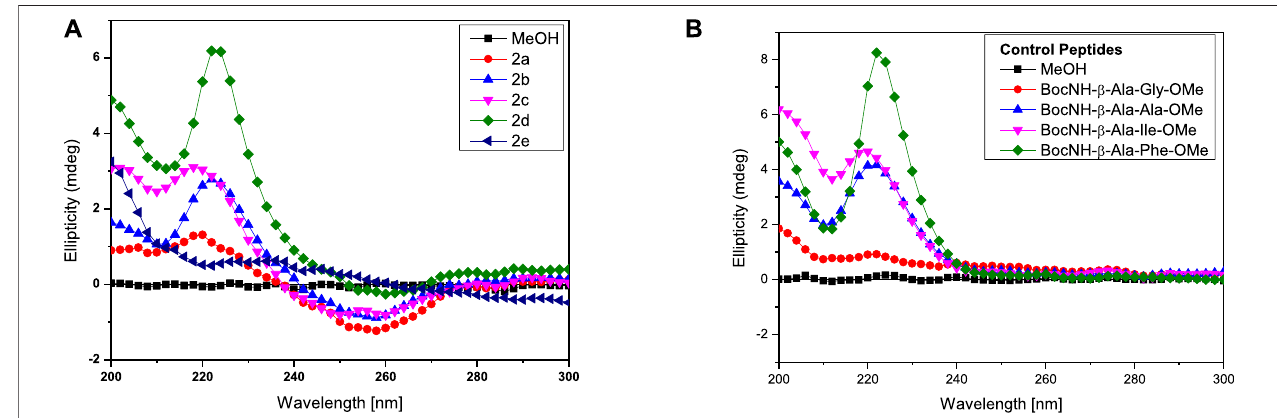
FIGURE 3 | CD spectra of hybrid peptides in MeOH. APA-peptides (A) and control peptides (B) .